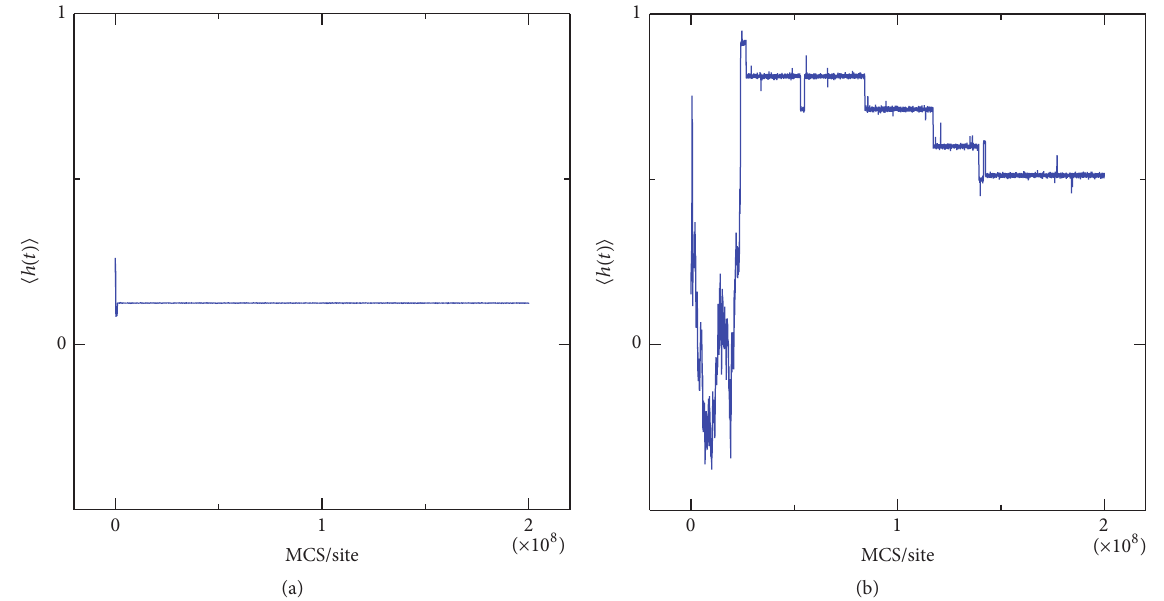
Figure 8: Time evolution of the averaged surface height in the step-faceting zone. (a) 𝑘 𝐵 𝑇/𝜖 = 0.2 . (b) 𝑘 𝐵 𝑇/𝜖 = 0.4 . 𝜖 int /𝜖 = −0.9 . 𝑁 step = 60 . Size: 80√2 × 80√2 .